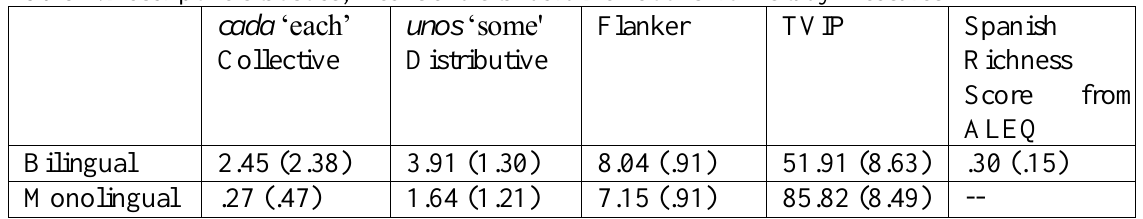
Table 1 . Descriptive Statistics, Means and Standard Deviations from Study Measures